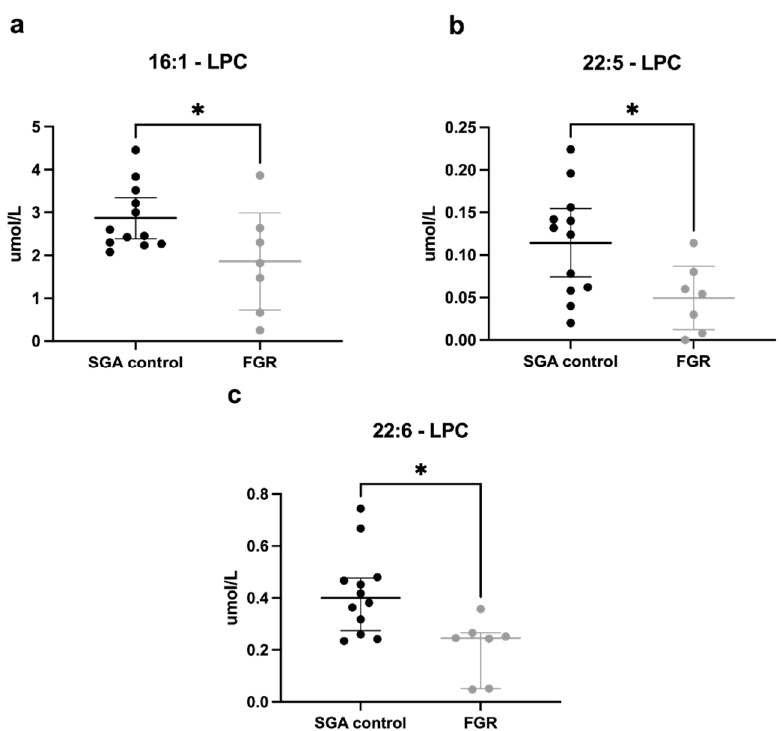
cord plasma compared to SGA controls.